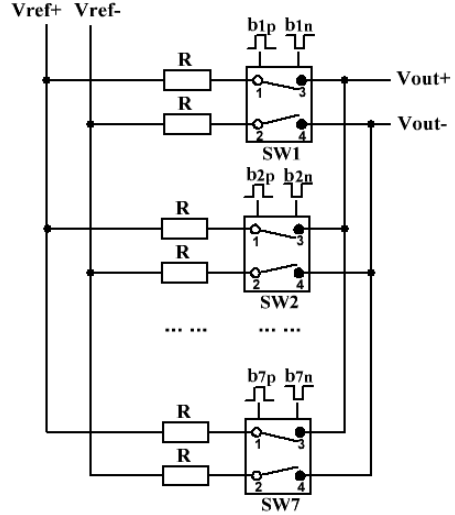
Figure 11. Schematic of the 3-bit resistance-type digital-to-analog converter (DAC).